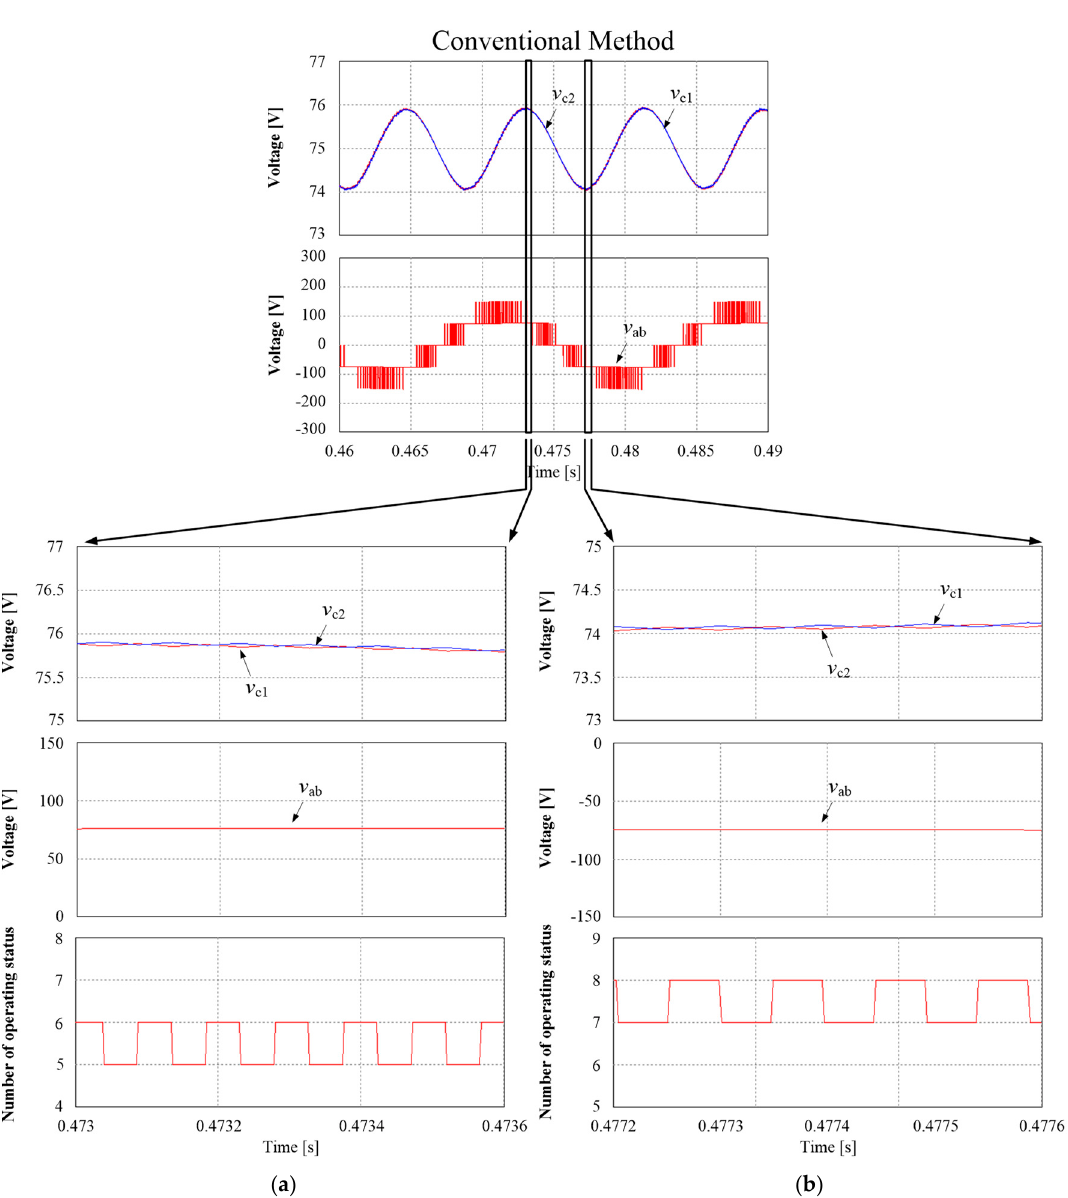
Figure 2. Simulation waveforms of conventional MPC method ( a ) during period with converter voltage v ab fixed to V dc /2 and ( b ) during period with converter input voltage v ab fixed to − V dc /2.